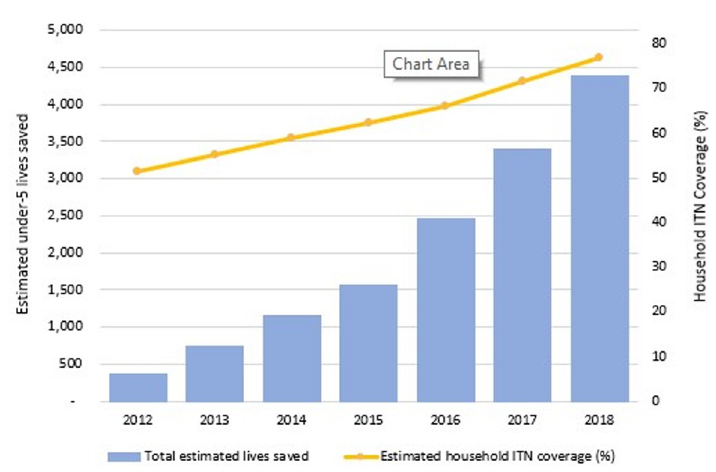
Fig 2. Mean household ownership coverage of ITNs and total estimated lives saved of children under-5 due to ITN ownership in 10 provinces of Mozambique, 2012 to 2018.